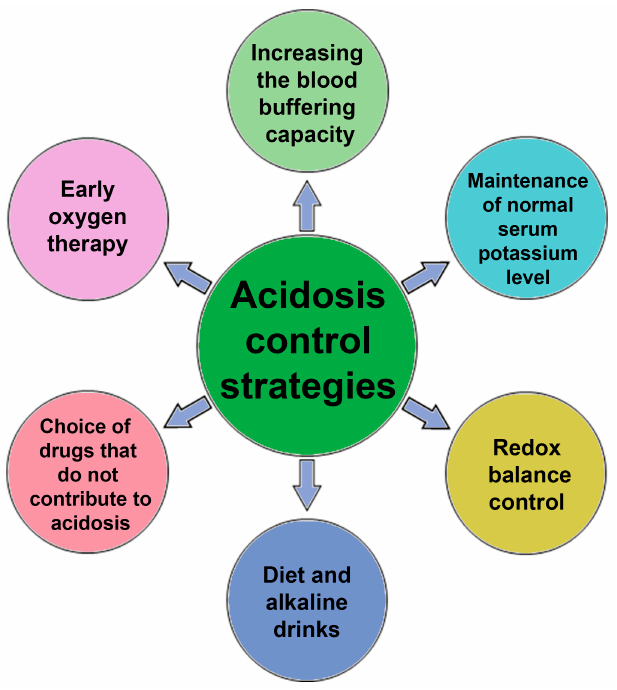
Figure 4. Scheme of possible interventions to combat acidosis in patients with COVID-19.